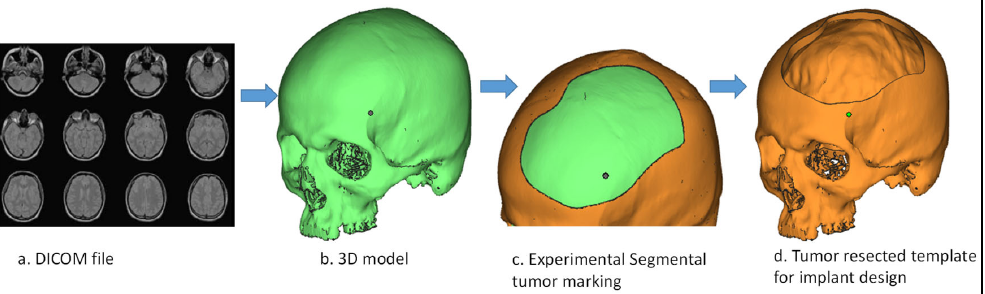
Figure 2. Steps involved in the reconstruction of a tumor ‐ resected implant template. ( a ) DICOM file. ( b ) 3D model. ( c ) Experimental Segmental tumor making. ( d ) Tumor resected template for implant design.